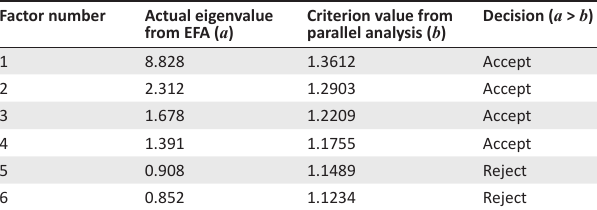
TABLE 5: Parallel analysis for student educational outcomes effectiveness questionnaire.